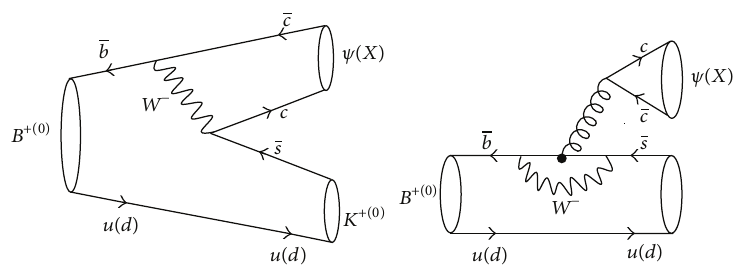
Figure 1: Quark diagrams illustration of the processes of the 𝐵 +(0) → 𝜓𝐾 +(0) and 𝑋𝐾 +(0) decays.